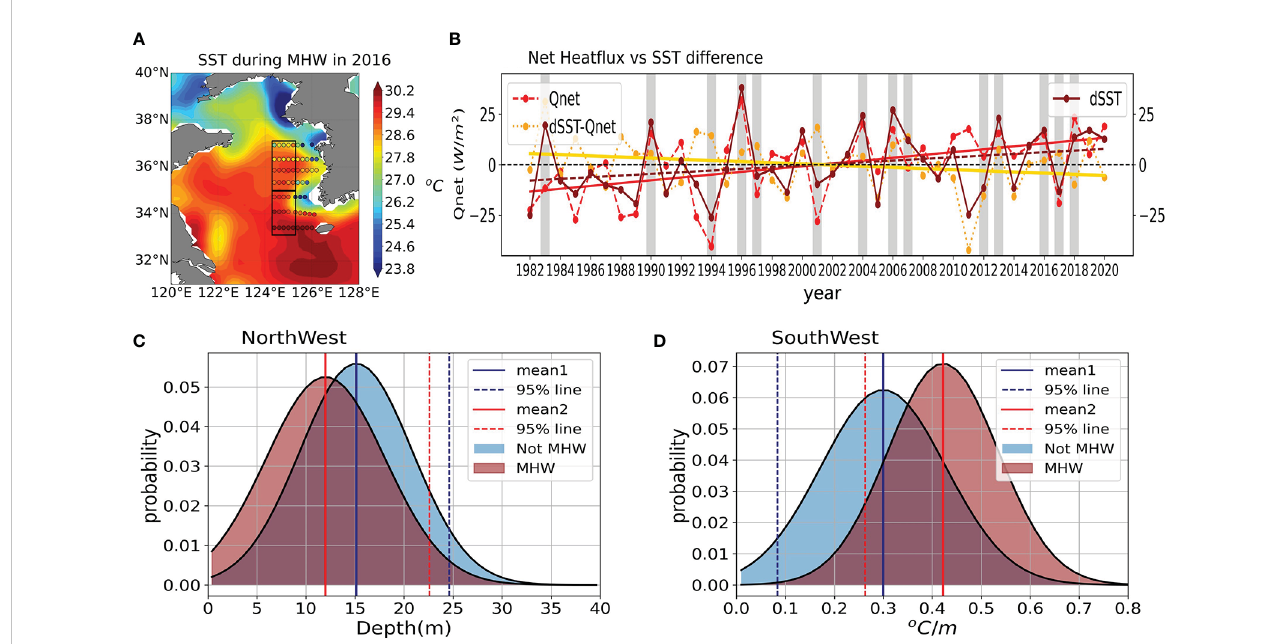
FIGURE 1 (A) Monthly average SST during the marine heat wave events in August 2016, based on OISST (Reynolds et al., 2007). Overlaid contour indicates the boundary of the heatwave at 27.3°C, the value of 90 th percentile of the August monthly mean. Colored dots are the NIFS temperature observation in August 2016. (B) Monthly average surface net heat fl ux anomaly calculated from mid-July to mid-August (red), overlaid with changes in SST anomaly (brown), and the residual (yellow), area averaged in the outer box (33.1~37.1°N, 124.3~126.3°E). The monthly change in SST anomaly was averaged from mid-July to mid-August using daily data. Gray bars indicate the years with the August MHWs detected in the area averaged daily OISST data. (C, D) probability mass function for depth of maximum vertical temperature gradient and the vertical temperature gradient at 20m depth over the Northwest and the Southwest domain, respectively, based on NIFS data in June, from 1982 to 2020. Shaded in blue for the years with no MHW and red for the years with